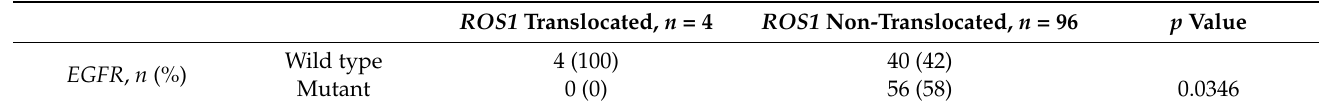
Table 2. Relationship between ROS1 and EGFR in lung cancers. ROS1 Translocated, n = 4 ROS1 Non-Translocated, n = 96 p